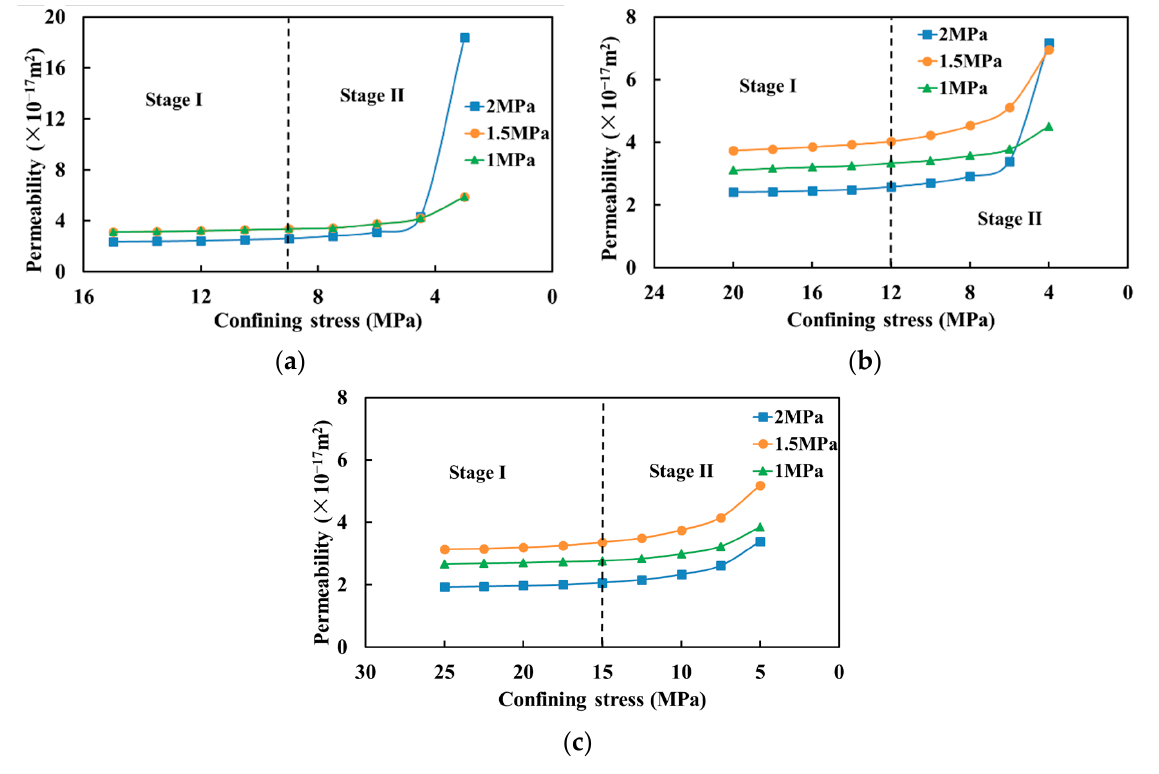
Figure 9. Permeability variation of sandstone under different initial confining pressures (( a – c ) are the initial confining pressure of 15 MPa, 20 MPa, and 25 MPa, respectively).